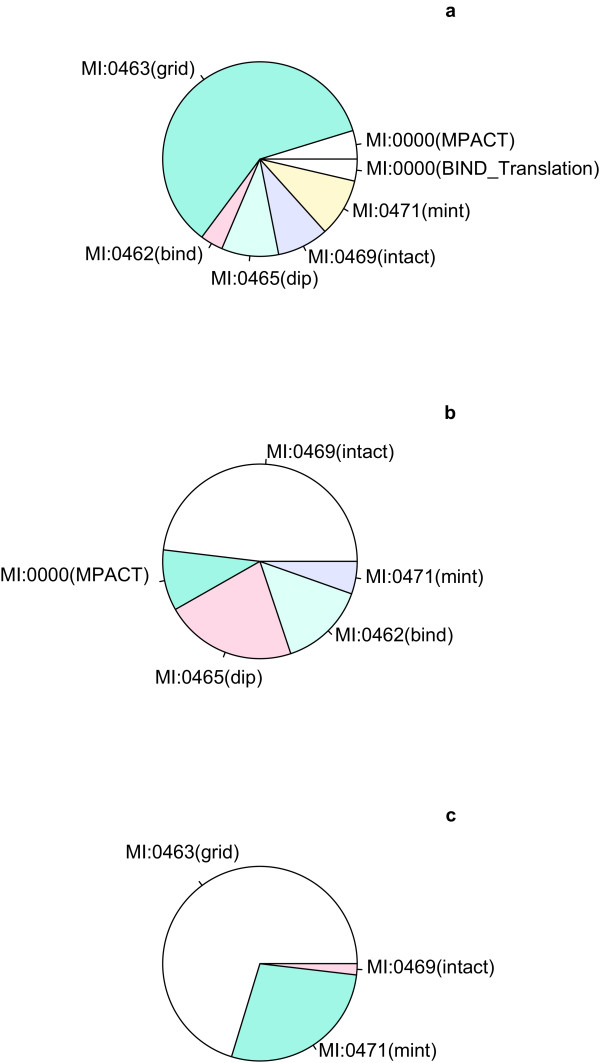
Statistics per source database.a. Division of all binary interaction records by source database. The majority of binary interactions come from the BioGrid database. The molecular interaction ontology controlled vocabulary term identifiers are given for each database (e.g. MI:0463 for BioGrid. b. Division of all n-ary interaction records (3 or more interactors per record) per source database. IntAct and DIP are the main sources. c. Binary interaction records used to create regenerated complexes per source database. The main source is BioGrid, followed by MINT. BioGrid represents all information as binary data (i.e. n-ary data is represented as binary data using a spoke-model).